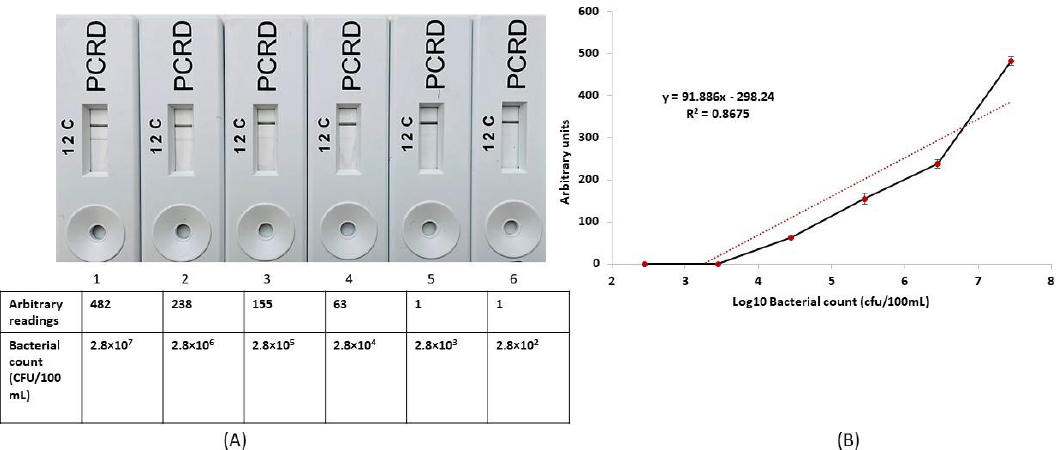
Figure 6. ( A ) Comparison of the RPA-LFA visual outputs and the values recorded by the GT810. ( B ) Standard curve plot of bacterial cell numbers v GT810 readings; ( • ) represents the value produced by the LF reads corresponding to the CFU count of bacteria per 100 mL of growth medium.